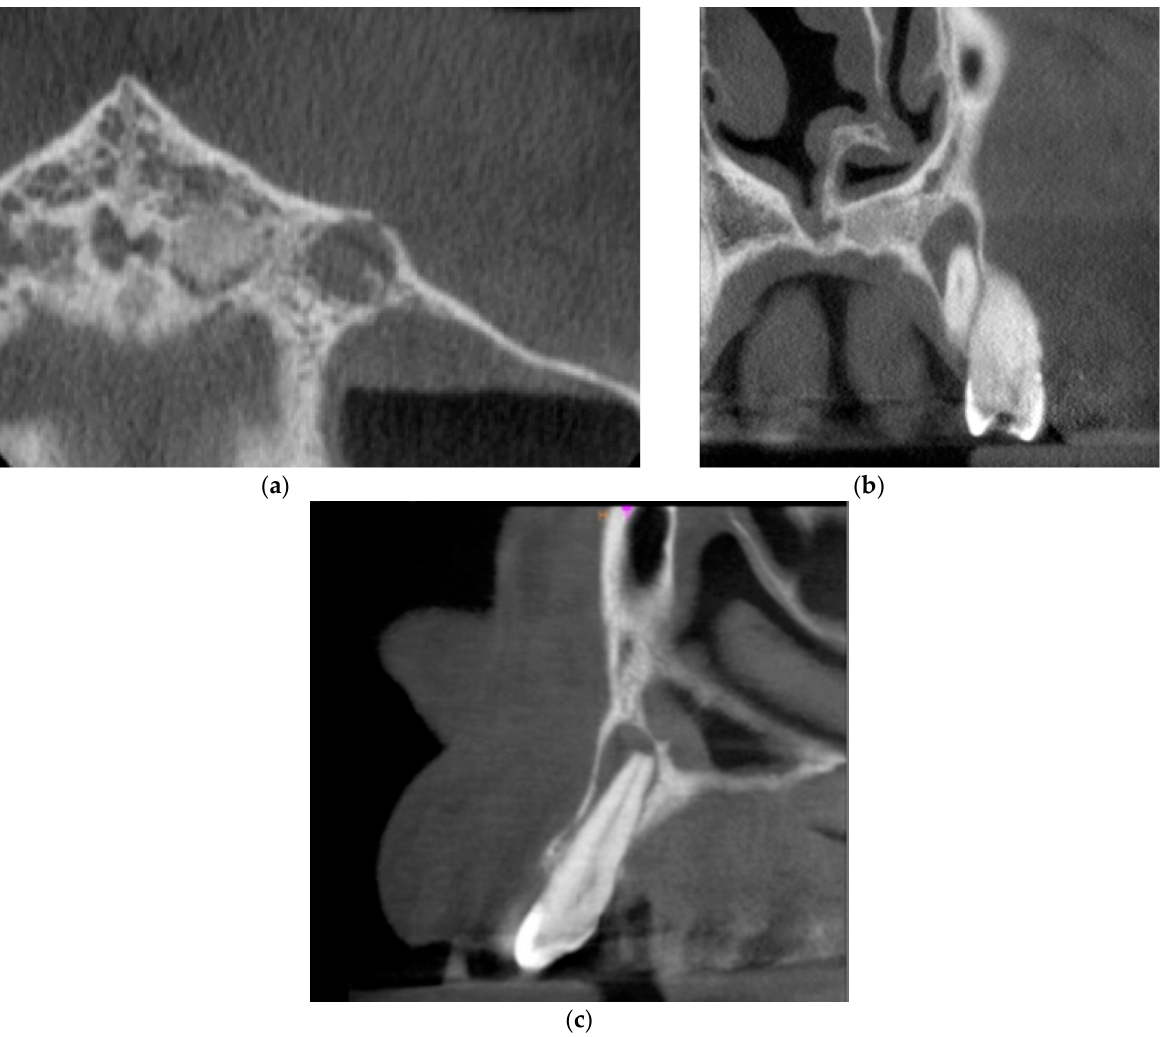
Figure 1. Preoperative cone beam computerized tomography (CBCT) images presenting the periapical lesion around the root of tooth no. 23 (date of CBCT examination: 22 May 2020): ( a ) axial view; ( b ) coronal view; and ( c ) sagittal view.